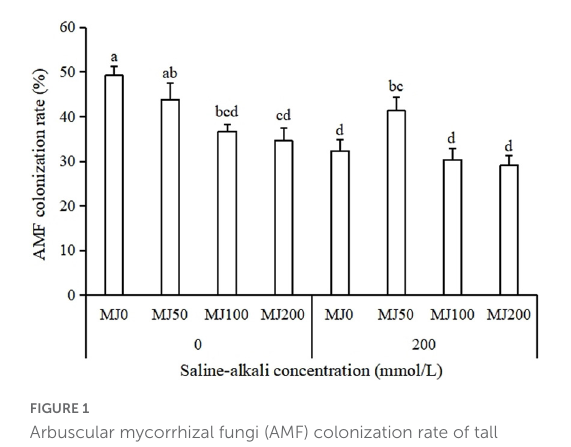
FIGURE1 Arbuscular mycorrhizal fungi (AMF) colonization rate of tall fescue root as effects by the interaction between different methyl jasmonate (MeJA) levels (0 MeJA = 0 mg/L, 50 MeJA = 50 mg/L, 100 MeJA = 100 mg/L, 200 MeJA = 200 mg/L) and saline-alkali stress. Different letters above the bars indicate significant differences according to Duncan’s multiple range test ( P ≤